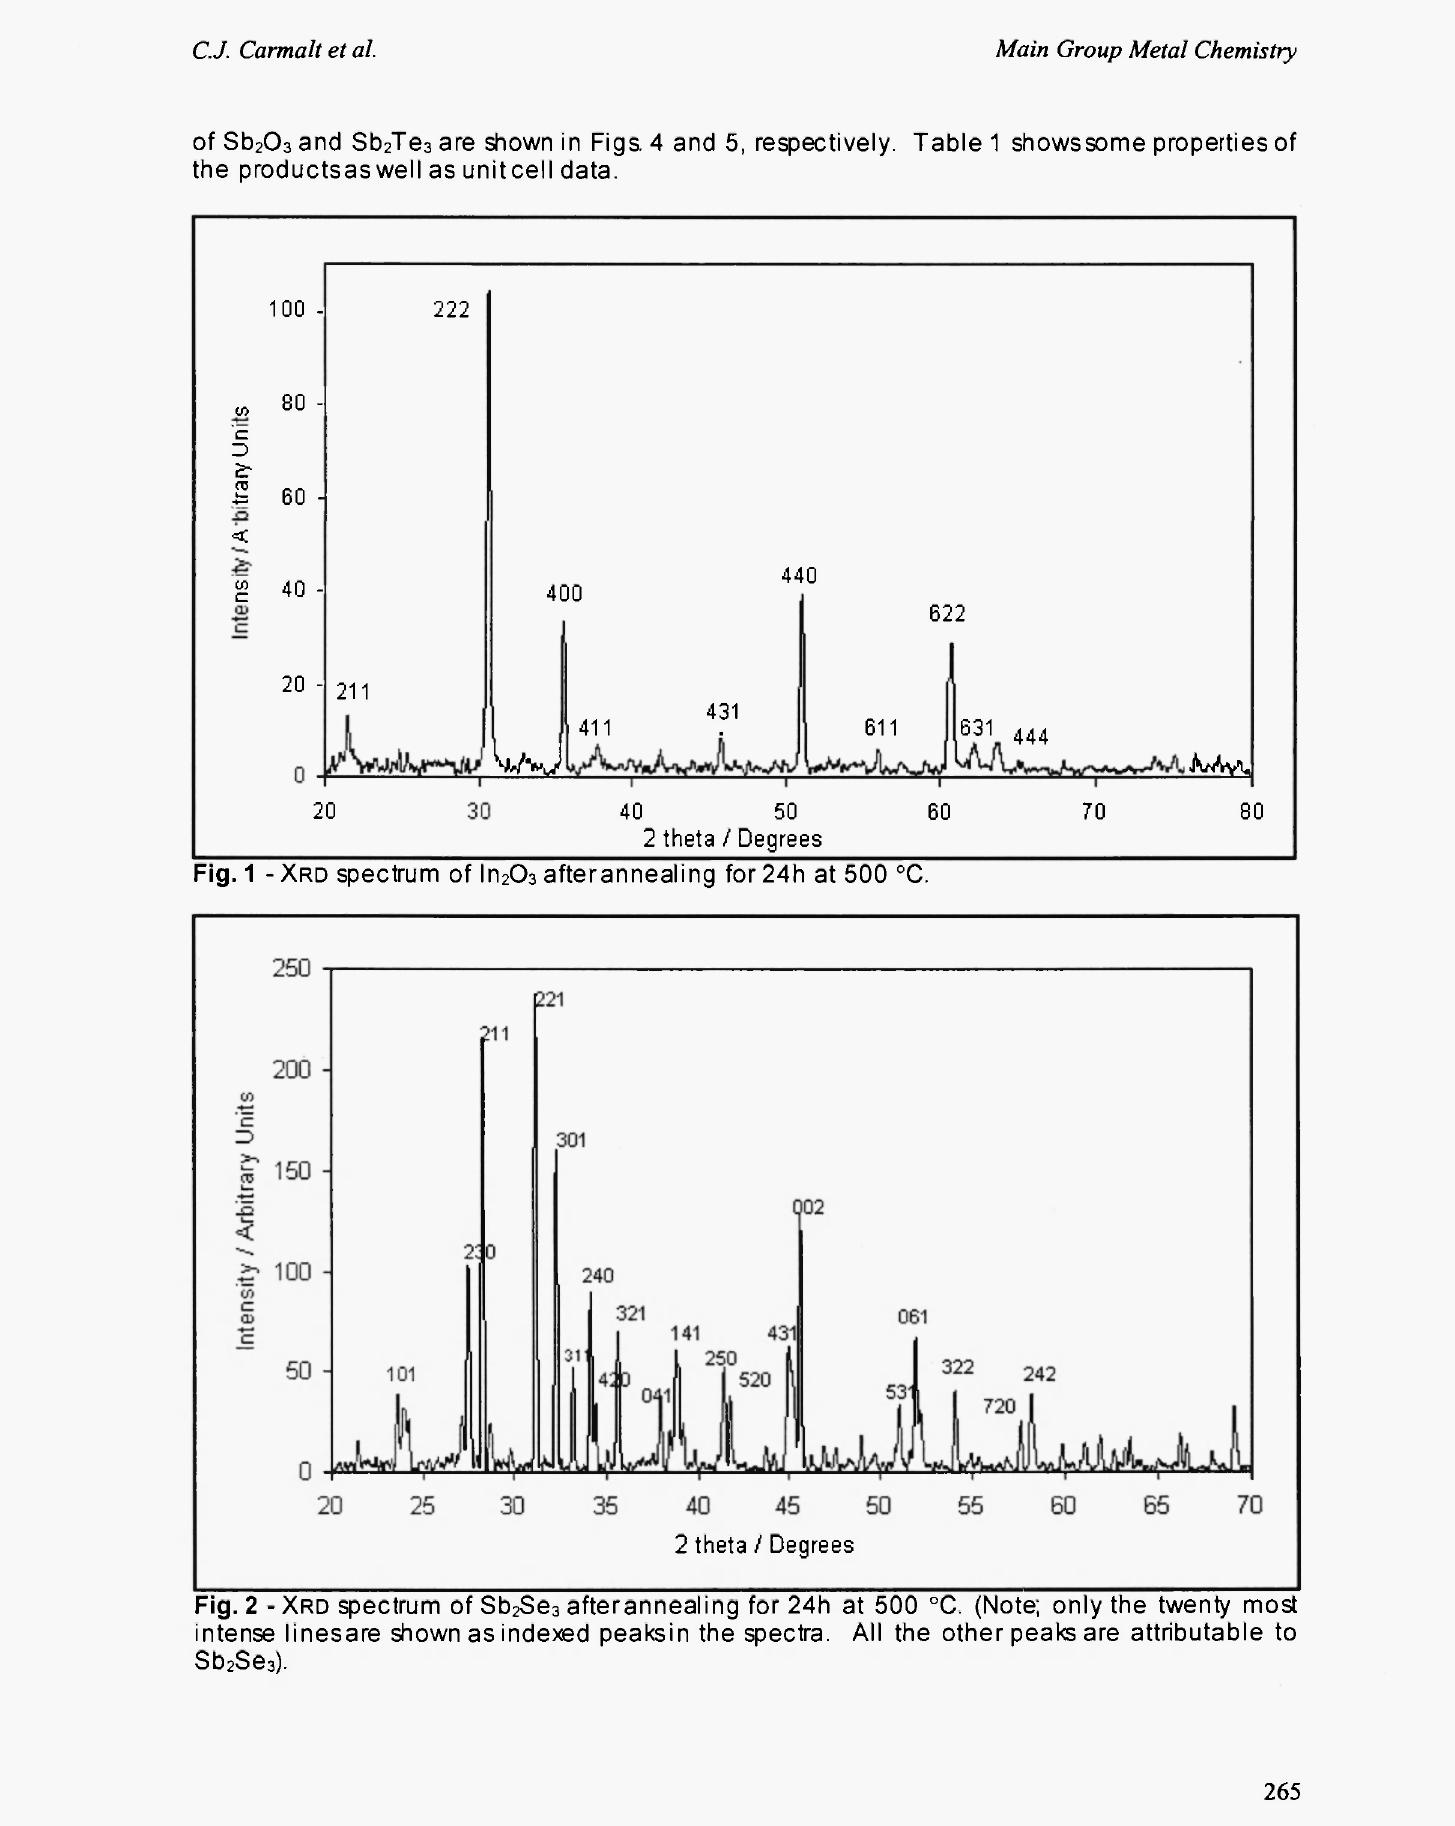
Fig. 2 - XRD spectrum of Sb 2 Se 3 afterannealing for 24h at 500 °C. (Note; only the twenty most intense linesare shown as indexed peaksin the spectra. All the other peaks are attributable to Sb 2 Se 3